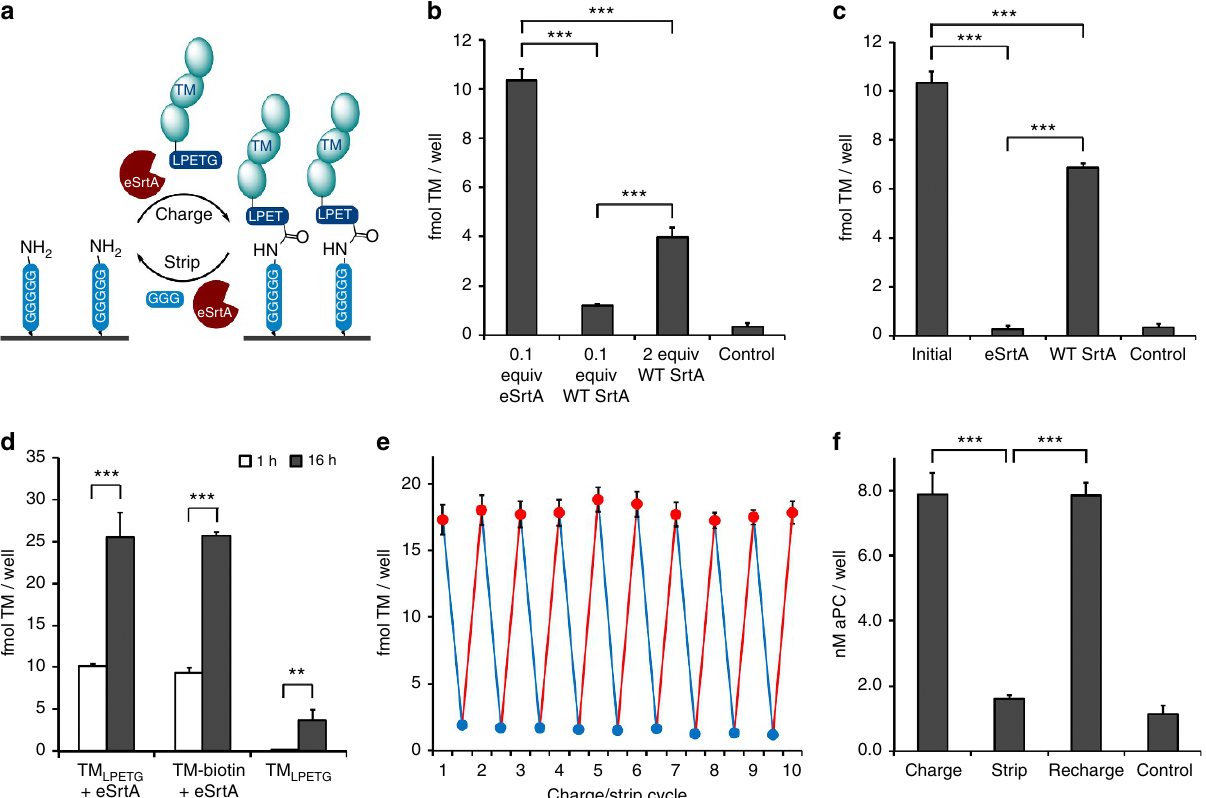
Figure 1 | Sortase-catalysed rechargeable surface assembly. ( a ) Two-step ‘rechargeable’ surface assembly cycle initiated by sortase-catalysed charging of LPETG-tagged biomolecules on pentaglycine-modified surfaces, followed by sortase-catalysed stripping to regenerate pentaglycine anchor sites for additional surface reaction cycles. ( b ) Immobilization of 1 m M TM LPETG on pentaglycine-coated microwells using 0.1 molar equivalents evolved sortase (eSrtA), 0.1 and 2 molar equivalents WT SrtA, or no sortase as a negative control. ( c ) Following immobilization of 1 m M TM LPETG on pentaglycine-coated microwells using 0.1 molar equivalents eSrtA, removal of bound TM was carried out using 20 m M of either evolved eSrtA or WT SrtA with 1mM